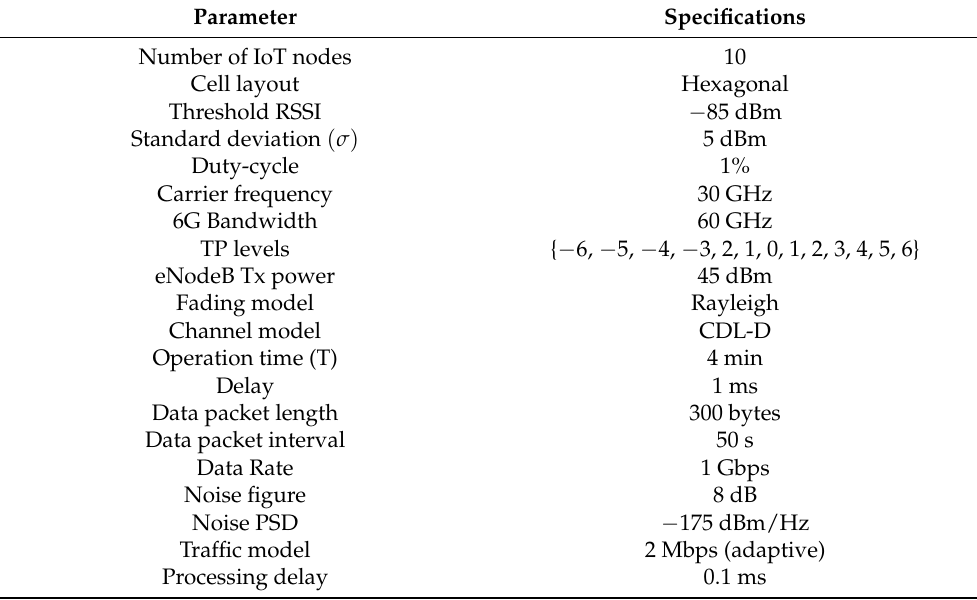
Table 2. Experimental